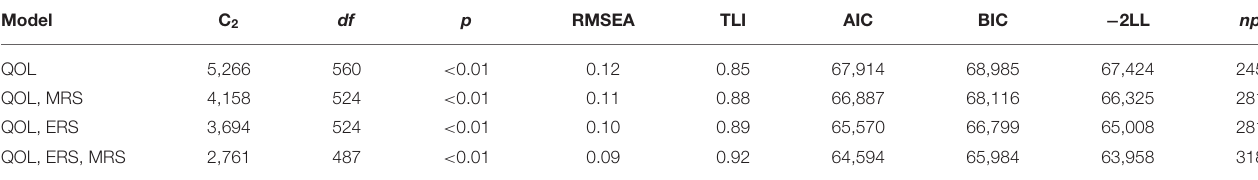
TABLE 4 | Summary of model fit for quality of life